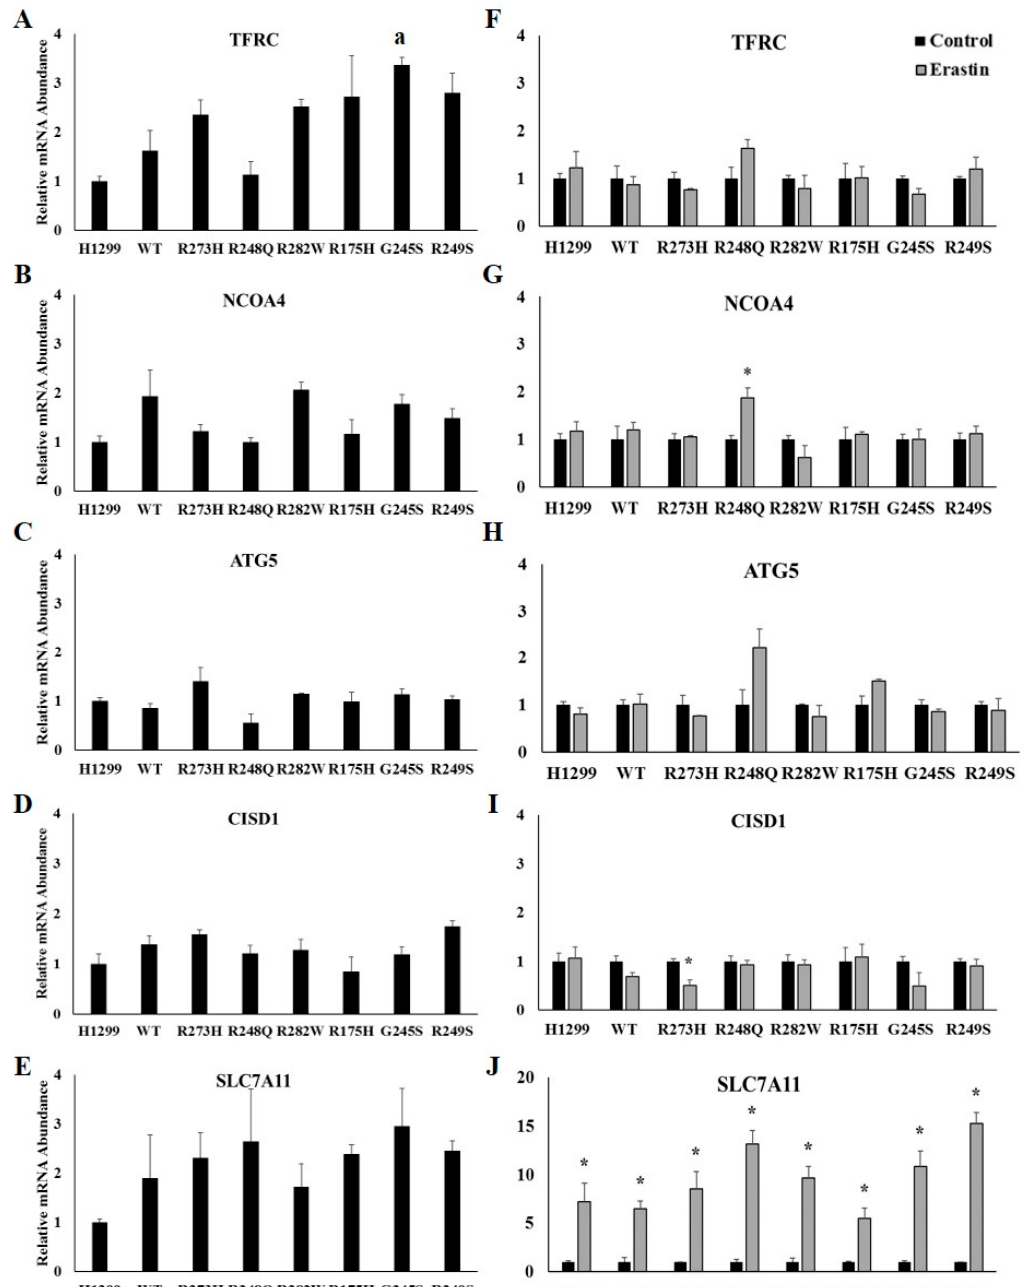
Figure 3. Iron-uptake and ferritinophagy-related gene expression are not affected by TP53 mutation status or erastin treatment. Relative mRNA expression of ( A ) transferrin receptor 1 (TFRC) ( B ) nuclear receptor coactivator 4 ( NCOA4 ), ( C ) autophagy related 5 ( ATG5 ), ( D ) CDGSG iron sulfur domain 1 ( CISD1 ), and ( E ) solute carrier family 7 member 11 ( SLC7A11 ) in TP53 null H1299 cells (H1299) or H1299 cells transfected with wild-type (WT) TP53, or the indicated TP53 mutant ( n = 3 per cell type and treatment group). Relative mRNA expression of ( F ) TFRC , ( G ) NCOA4 , ( H ) ATG5 , ( I ) CISD1 , and ( J ) SLC7A11 in TP53 null H1299 cells (H1299) or H1299 cells transfected with wild-type (WT) TP53, or the indicated mutant TP53 following treatment with DMSO (control) or 10 µM erastin for 24 h. a Denotes statistical difference from H1299. * Denotes statistical differences from respective control, p < 0.05. Error bars indicate SEM.